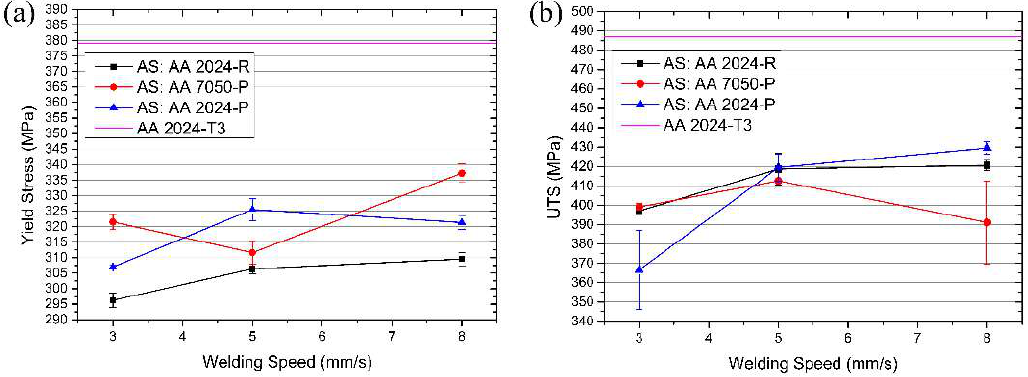
Figure 17. Variation in the ( a ) YS and ( b ) UTS with changing WS, the material position and direction.